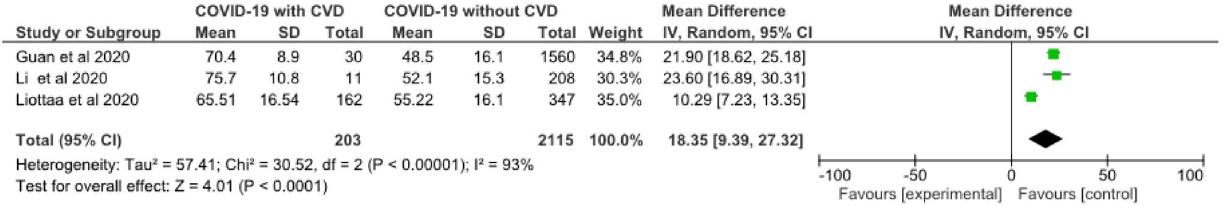
Fig. 3 Forest plot of the mean age of COVID-19 cases with and without neurological